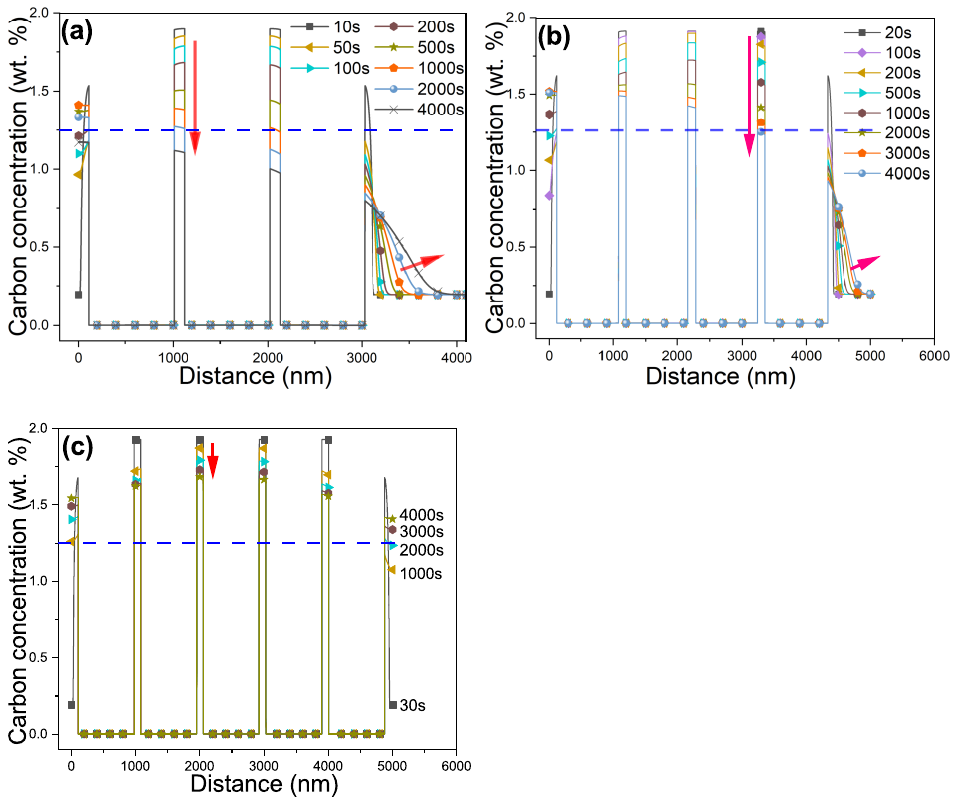
Figure 4. Carbon concentration profiles evolution in film-like and blocky austenite after local equi- librium for partitioning time of 10 to 4 × 10 4 s, at ( a ) 330 ◦ C, ( b ) 310 ◦ C, and ( c ) 292 ◦ C. The right domain represents the blocky austenite. The blue dash line denotes the critical carbon concentration above which the untransformed austenite will remain stable when quenched to room